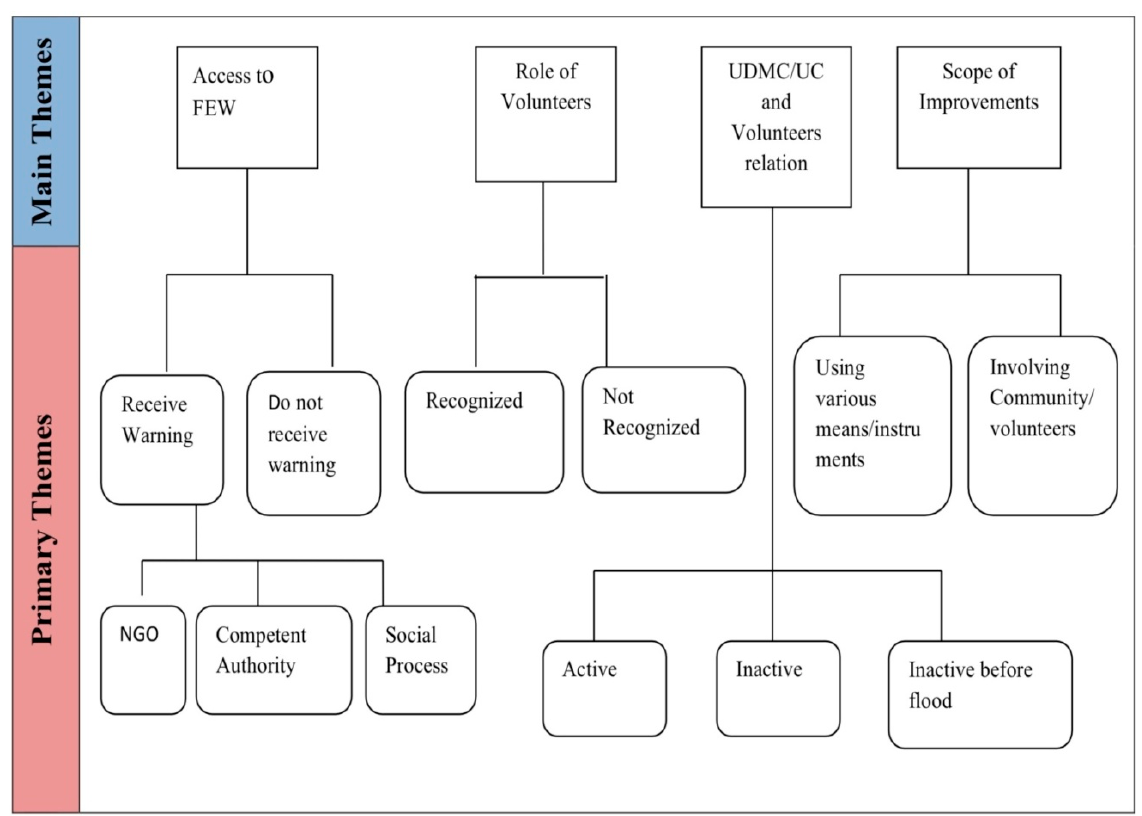
Figure 3. Schematic representation of the thematic map followed in this study to investigate the relationship of community volunteers with FEW.